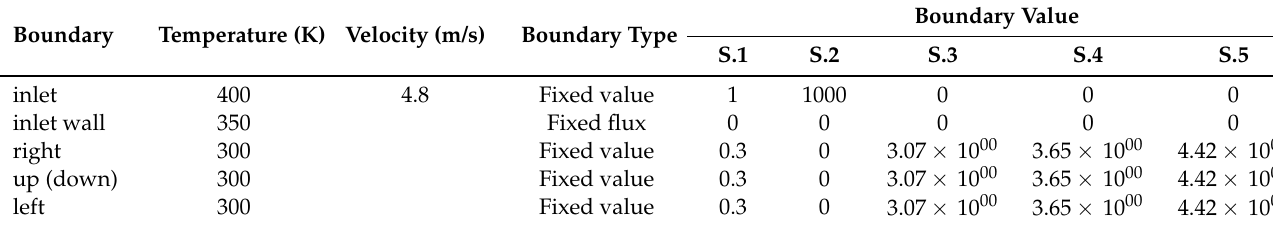
Table 3. Example boundary setting of nonpolluted